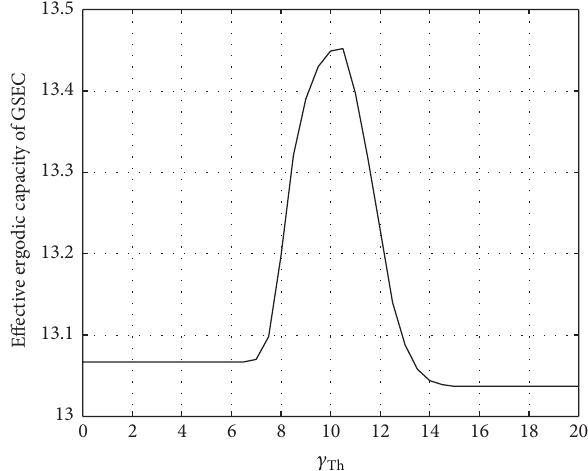
Figure 6: Effective ergodic capacity VS. 𝛾 = 20 , 𝐿 = 4 , 𝐷 = 𝐷 = 𝜆 ). 𝑁 𝑅 𝑅 𝑇 𝑅